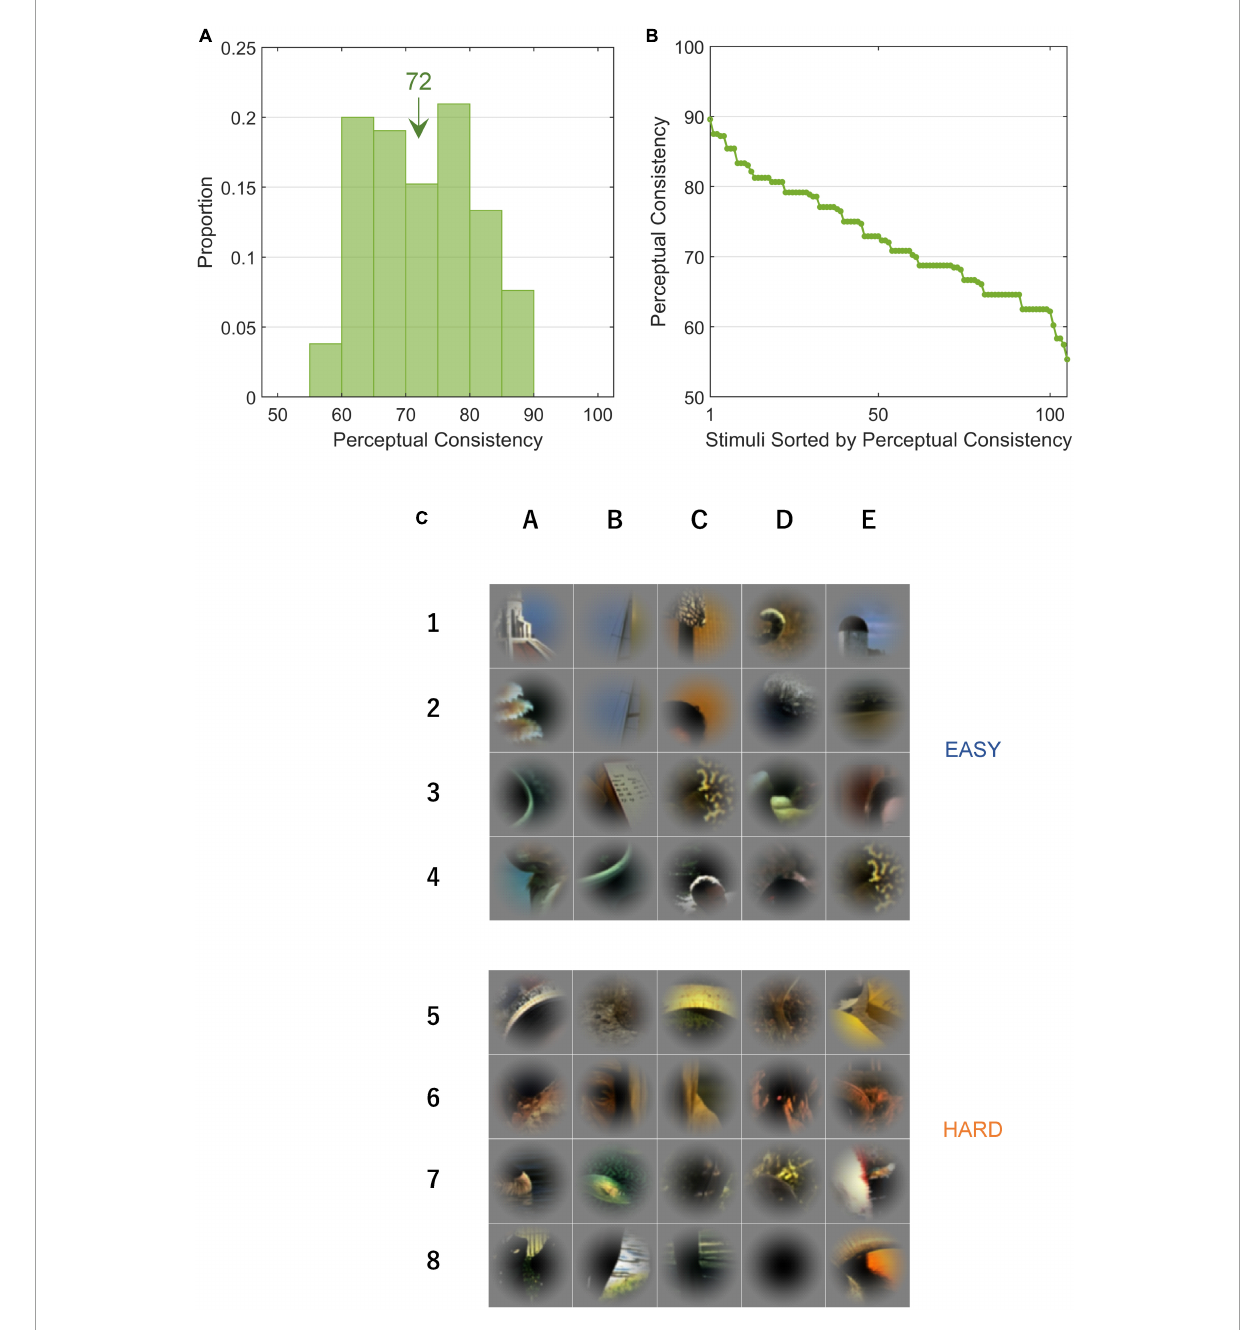
FIGURE3 Perceptual consistency and EASY/HARD stimuli. PC is an index that indicates the ease with which a figure was perceived. (A) The distribution of PC for all stimuli. The inset value indicates the mean. (B) PCs in rank order. (C) The top and bottom panels (rows 1–4 and 5–8) show EASY and HARD stimuli, respectively (20 original stimuli with the highest and lowest PCs, respectively). Unlike Figure 1 , the patches were not rotated.